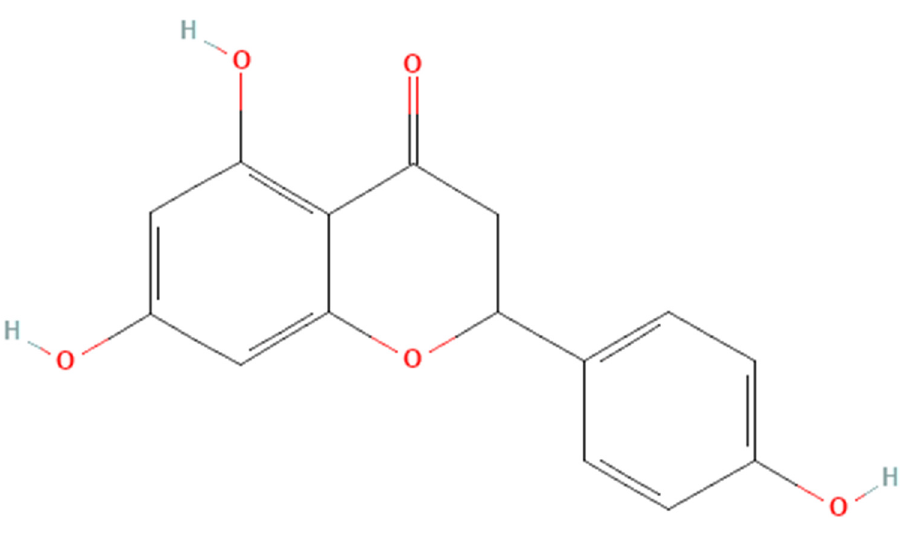
Figure 1. The molecular structure of naringenin.